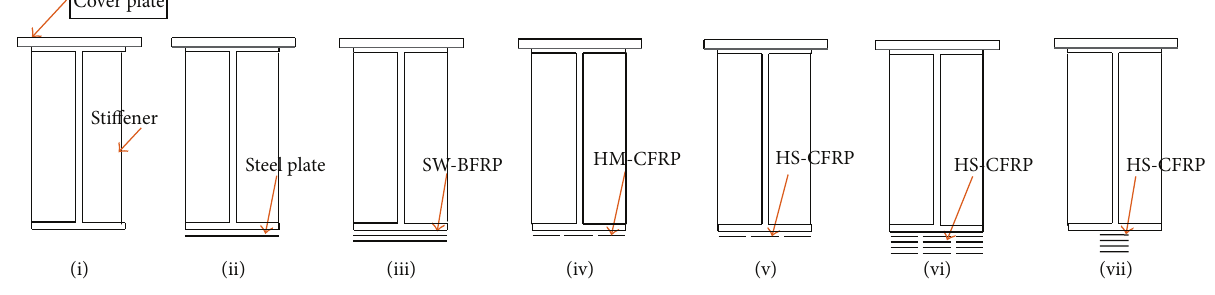
Figure 2: Strengthening technique with plate configuration